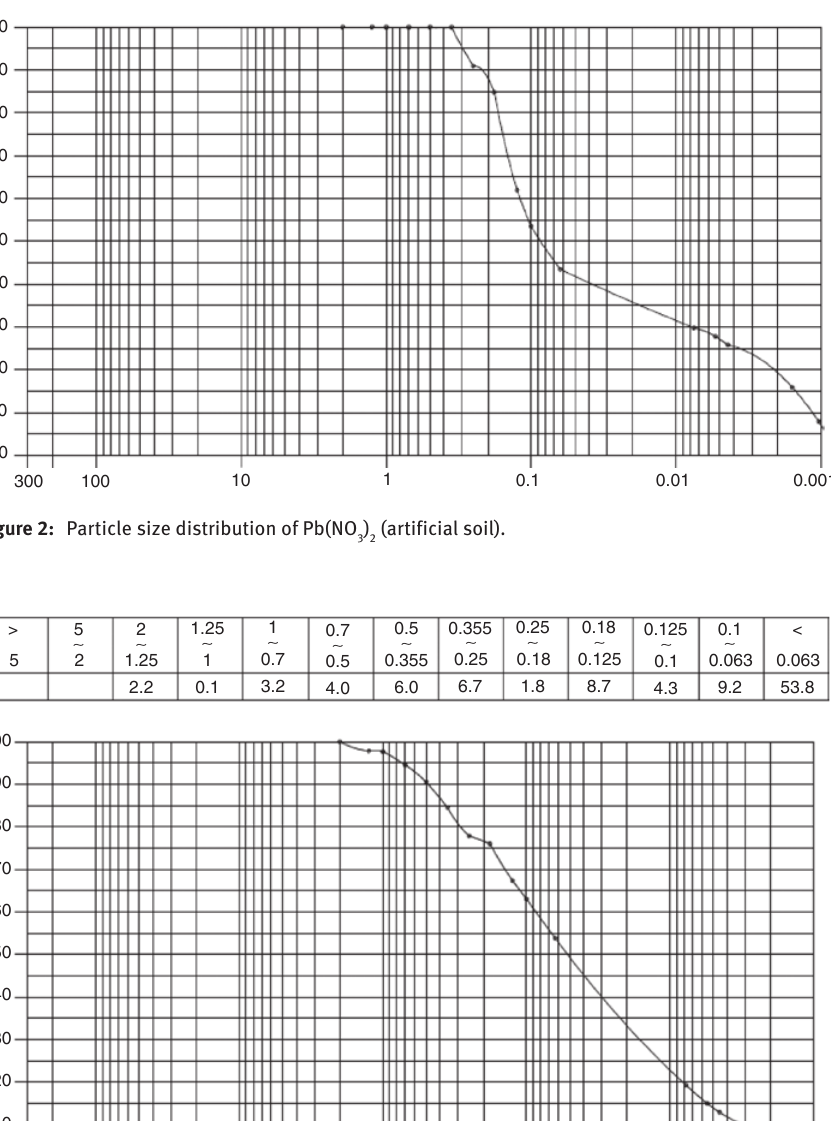
Figure 3: Particle size distribution of Cr (polluted